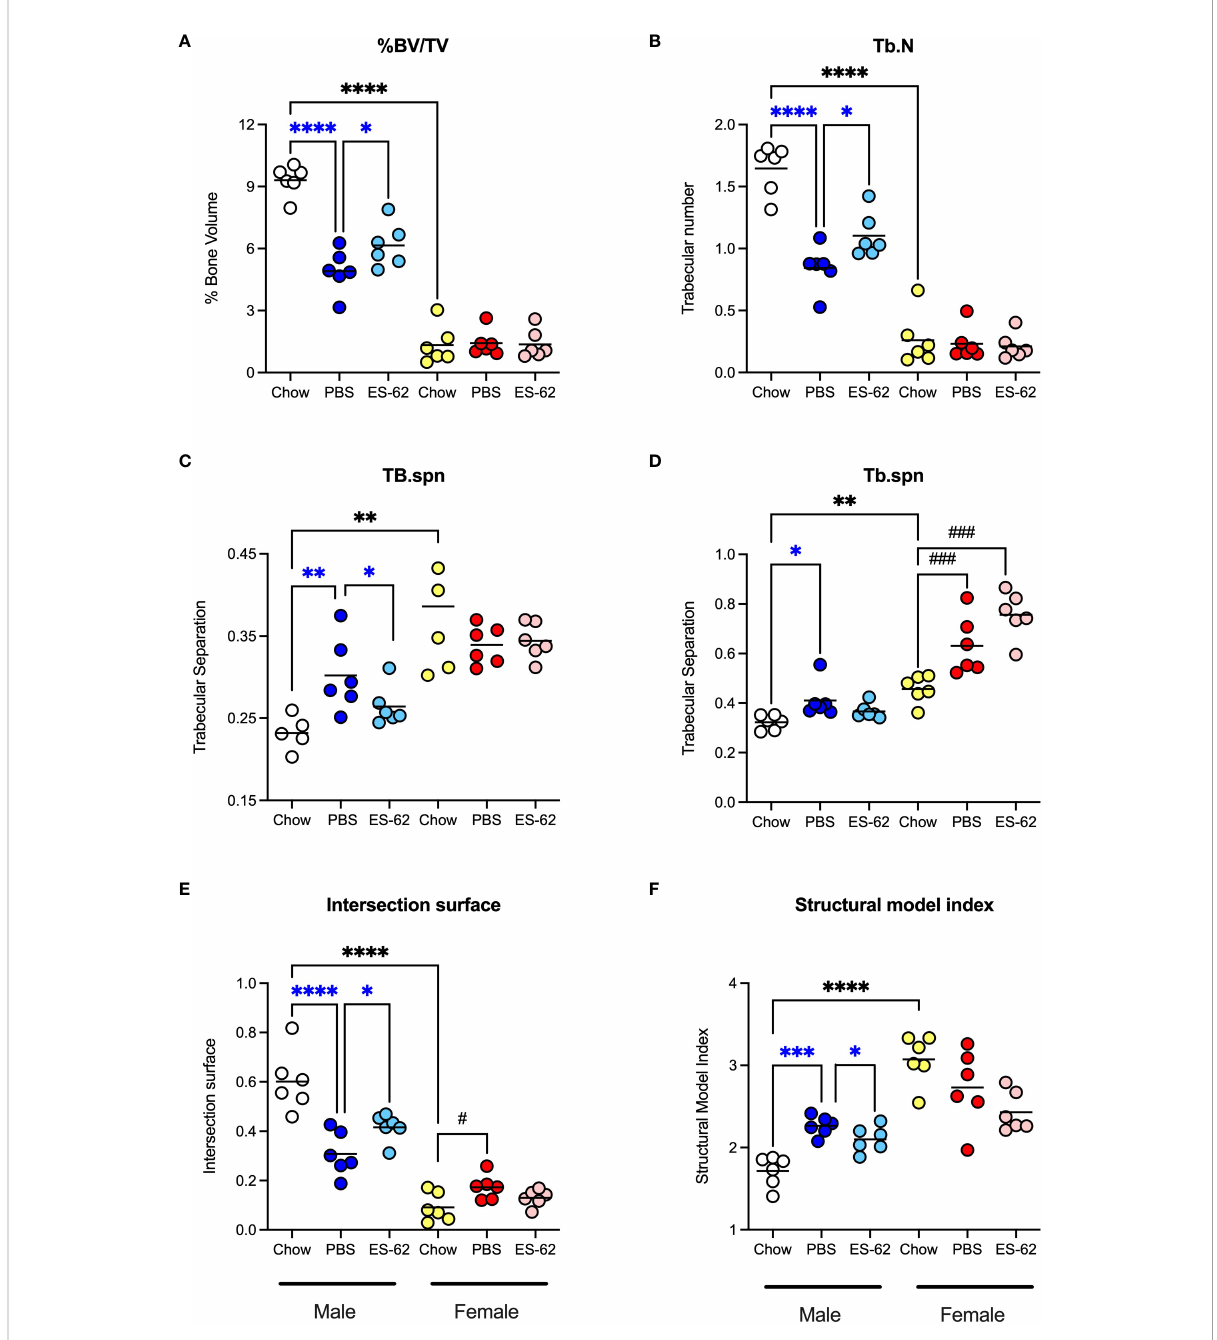
FIGURE 3 ES-62 protects against the HCD-accelerated changes in parameters of trabecular bone architecture in male mice. The effects of ES-62 on HCD (PBS)- and ageing-induced decline in bone structure homeostasis as evidenced by changes in (A) % Bone Volume/Tissue Volume (BV/TV) at d340; (B) Trabecular Number (Tb.N) at d340; (C) Trabecular Separation (Tb.spn) at d160; (D) Trabecular Separation (Tb.spn) at d340; (E) Intersection Surface at d340 and (F) Structure Model Index (SMI) at d340. The data shown are the values of femurs from individual mice (symbols) with the mean value for the group represented by the bar and signi fi cant differences indicated by blue****=p<0.0001 for male PBS v male Chow, blue***= p<0.001 for male PBS v male Chow, blue**=p<0.01 for PBS v male Chow, blue*=p<0.05 for male PBS v male Chow and blue*= p<0.05 for male PBS v male ES-62 (A – F) , black****= p<0.0001 for male Chow v female Chow and black**=p<0.01 for male Chow v female Chow (A – F) , black ### = p<0.001 for female Chow v female PBS or female ES-62 (D) and black # = p<0.05 for female Chow v female PBS (E)